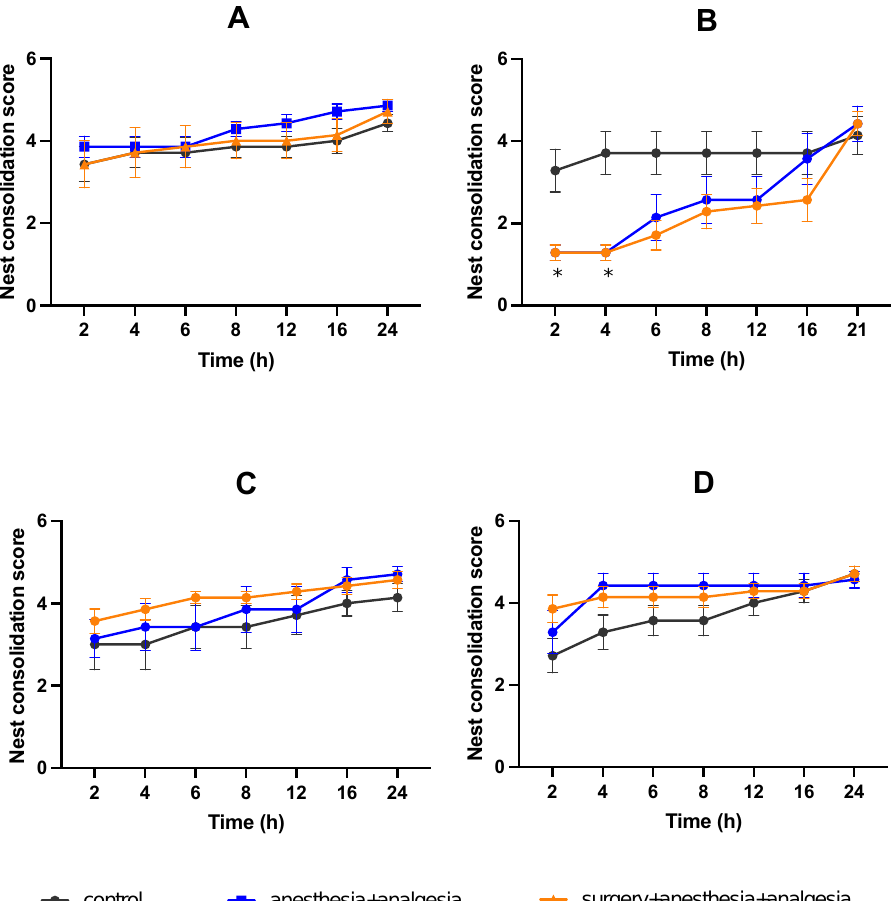
Figure 5. Comparison of the nest consolidation score (mean ± SE): ( A ) Day before treatment. ( B ) Day one. ( C ) Day two. ( D ) Day three . *, value differs ( p < 0.05) between the control and the anesthesia + analgesia groups. The control group: n = 7, the anesthesia + analgesia group: n = 7, the surgery + anesthesia + analgesia group: n = 7.